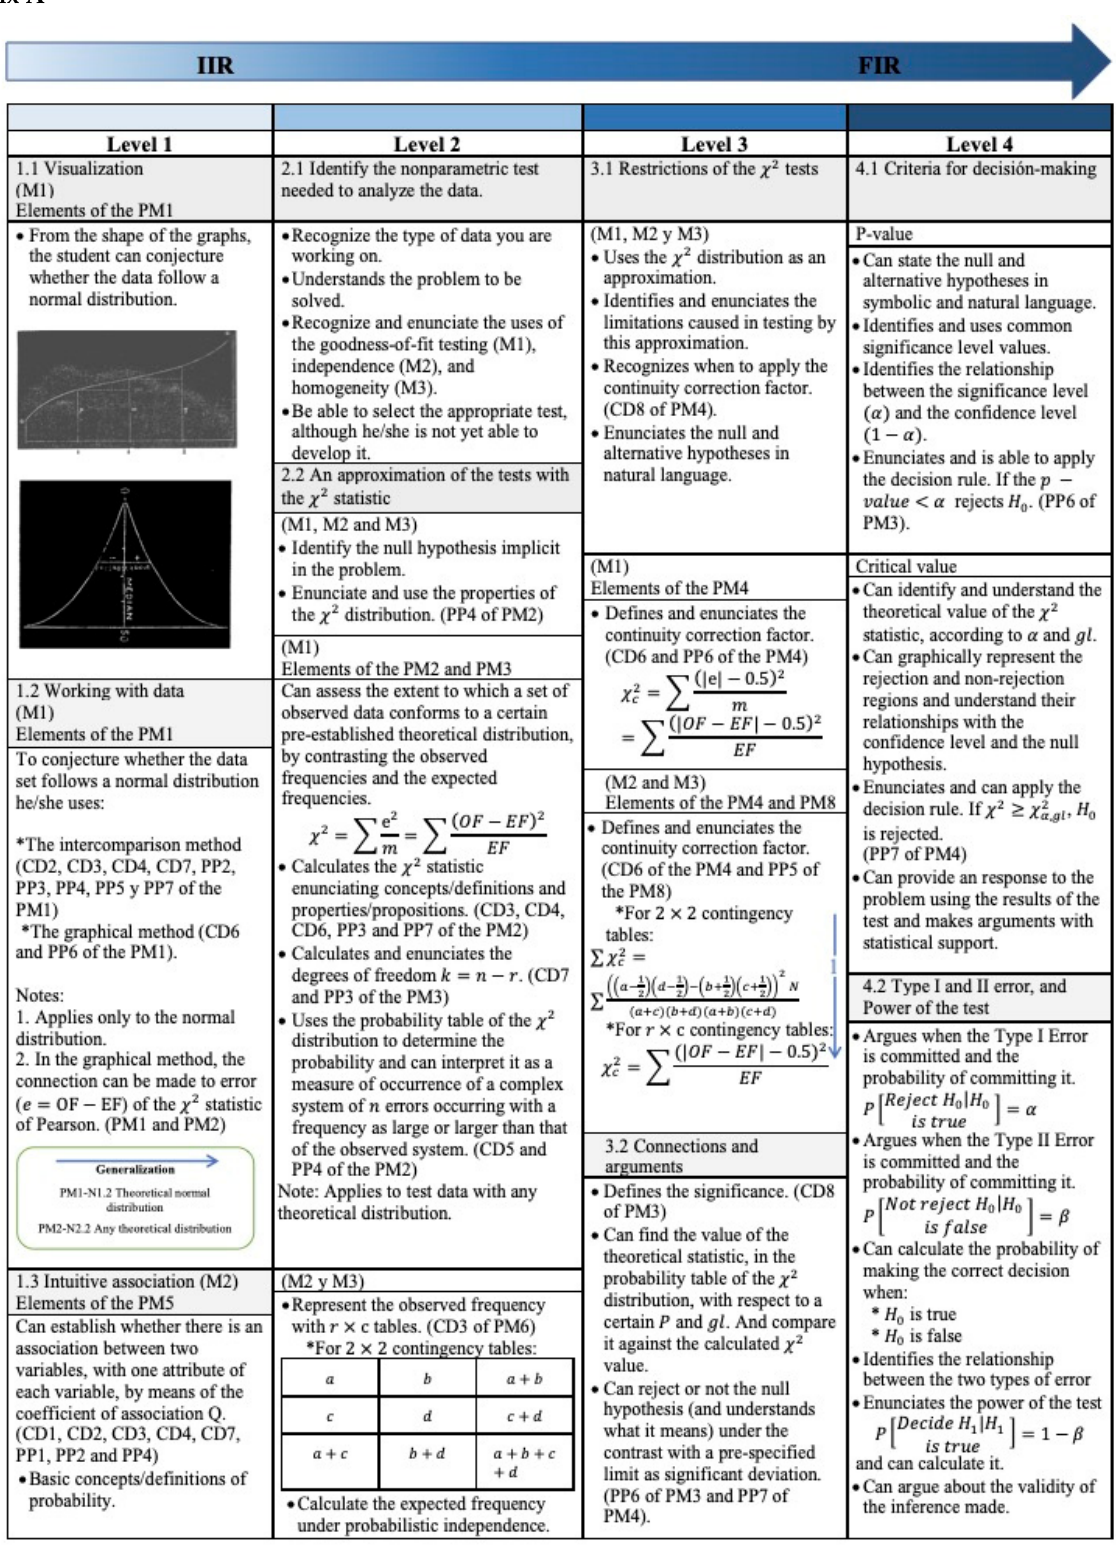
Figure A1. Levels of inferential reasoning on the Chi-square statistic (Part 1).